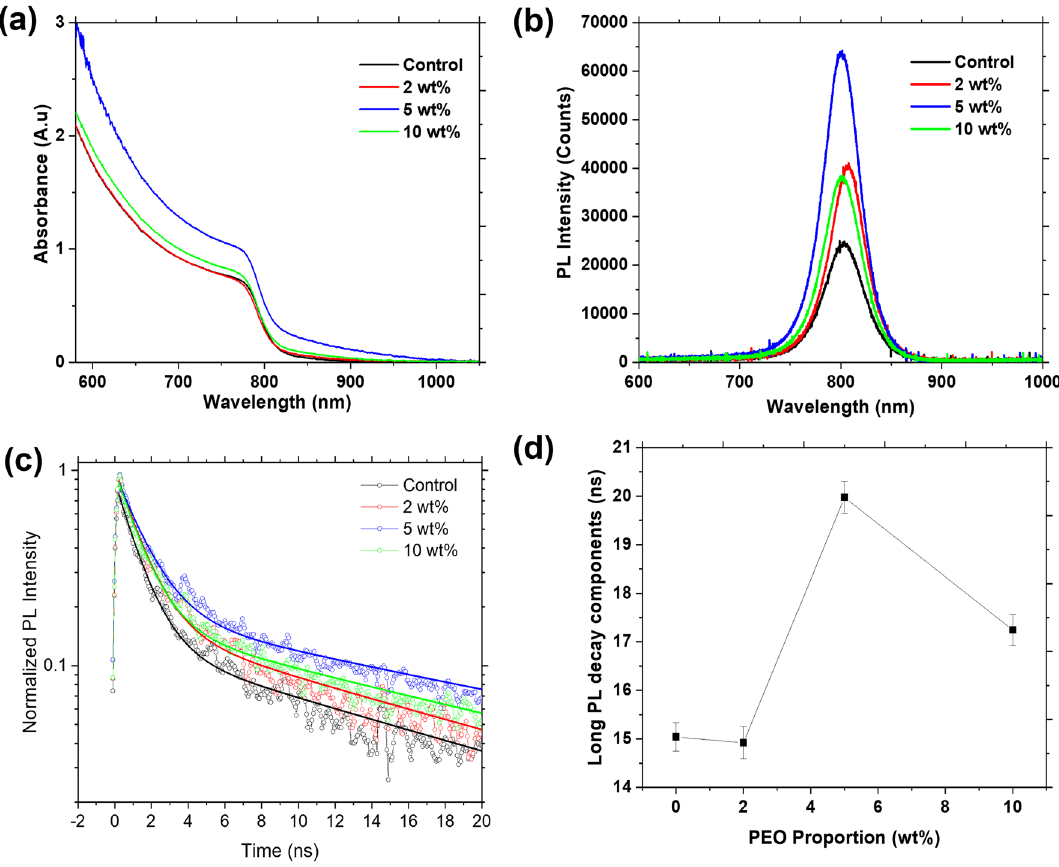
Figure 5. ( a ) UV–Vis spectra ( b ) steady stead PL, ( c ) TRPL and, ( d ) long decay lifetime as a function of wt% of PEO (Fluence 280 µJ/cm 2